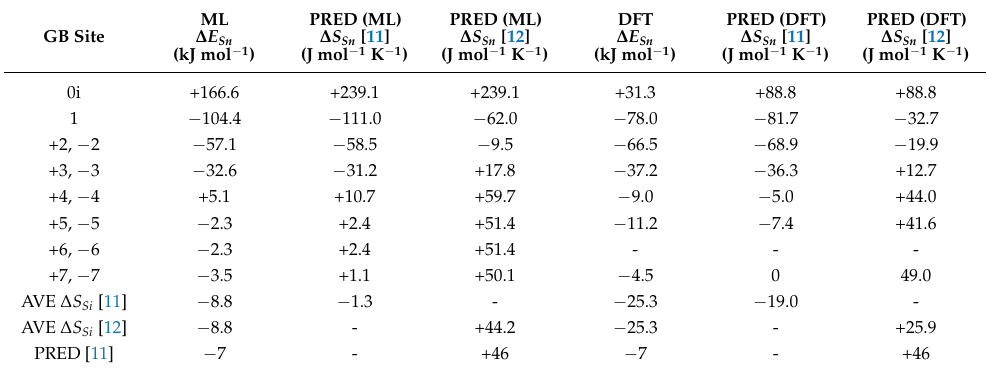
Table 3. Segregation energy calculated for the segregation of Sn at the {013} grain boundary. GB site, data calculated by ML and DFT in this work (0i, interstitial site, other sites are substitutional); PRED, prediction of ∆ S Si according to models [11,12]; AVE, averaged segregation energy according to calculated data for sites determined according to Equation (9) with ξ k = 1 and P = 14 or 12 (according to the number of considered grain boundary